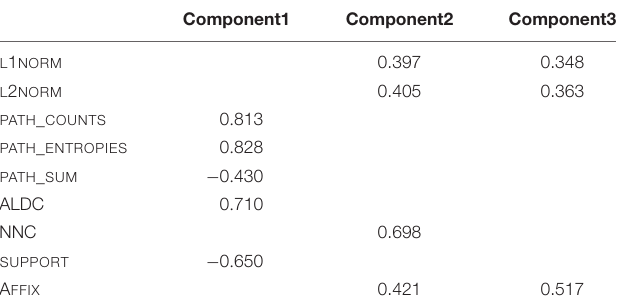
TABLE 3 | Loadings of original predictor variables in the three retained principal components of the first principal component